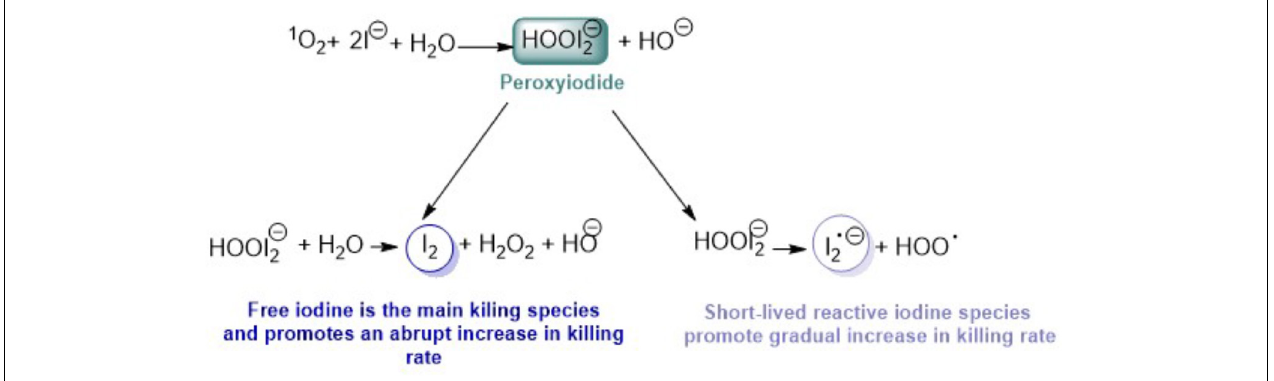
FIGURE 1 | Schematic representation of the decomposition of peroxyiodide produced by the reaction of 1 O 2 and KI (elaborated according with the literature – Vecchio et al., 2015; Zhang et al., 2015; Freire et al., 2016; Gsponer et al., 2016; Hamblin, 2017; Huang et al., 2017, 2018a; Kashef et al., 2017; Reynoso et al., 2017; Wen et al., 2017).